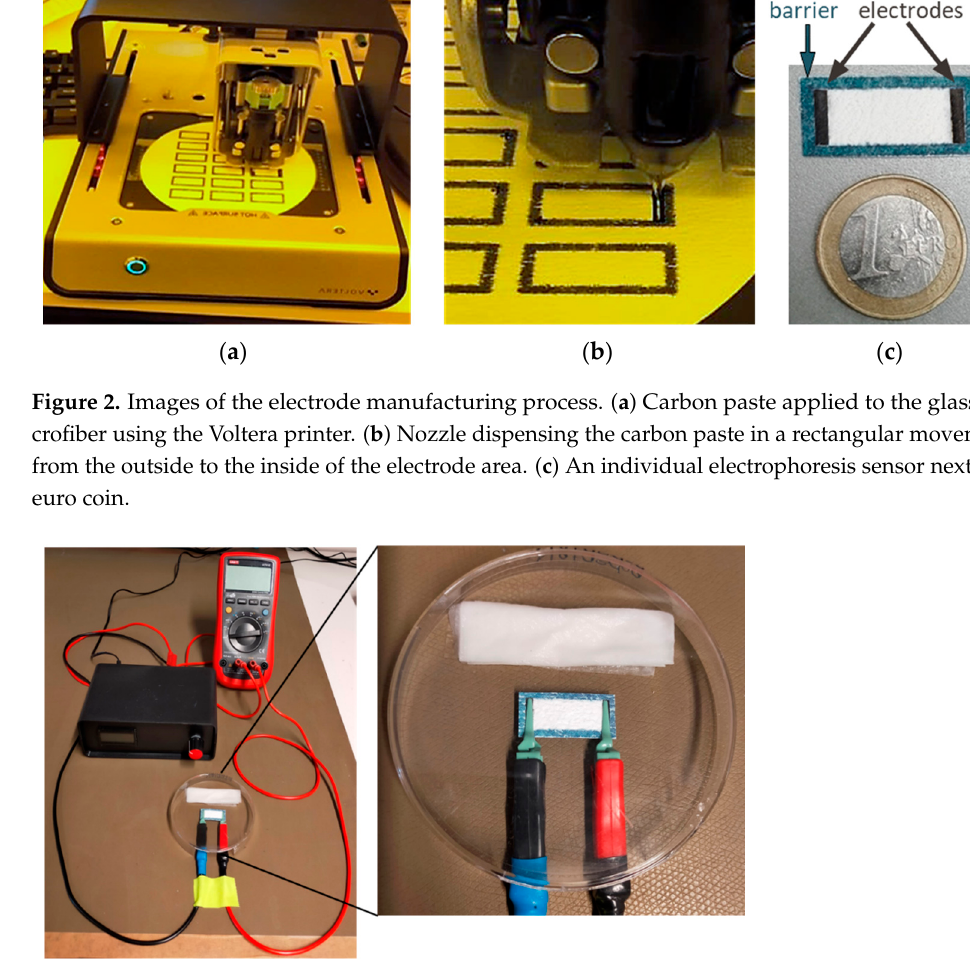
Figure 2. Images of the electrode manufacturing process. ( a ) Carbon paste applied to the glass mi- crofiber using the Voltera printer. ( b ) Nozzle dispensing the carbon paste in a rectangular move- ment from the outside to the inside of the electrode area. ( c ) An individual electrophoresis sensor next to a euro coin.